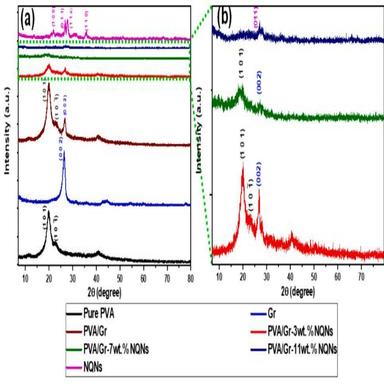
(a) XRD patterns of pure PVA, Gr, NQNs, and the nanocomposites: PVA/Gr, PVA/Gr-3 wt% NQNs, PVA/Gr-7 wt% NQNs, and PVA/Gr-11 wt% NQNs. (b) Zoomed-in XRD patterns of PVA/Gr-3 wt% NQNs, PVA/Gr-7 wt% NQNs, and PVA/Gr-11 wt% NQNs.